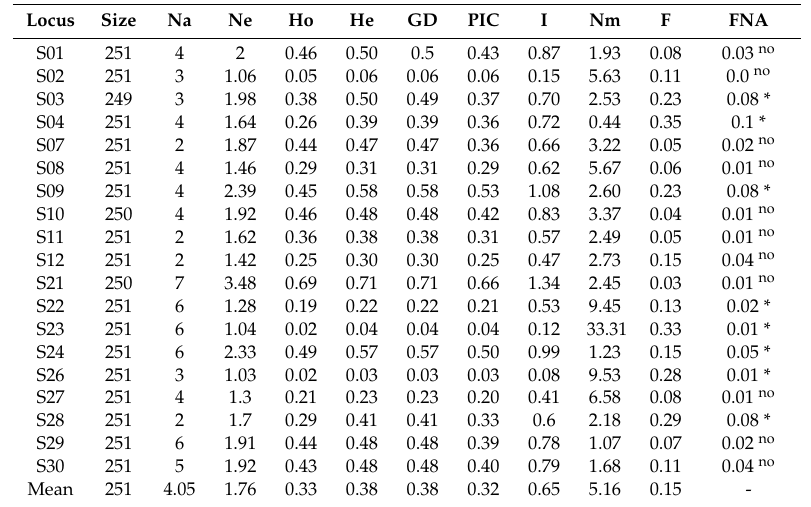
Table 1. Diversity statistics of the 19 microsatellite markers across Dalbergia odorifera germplasm.